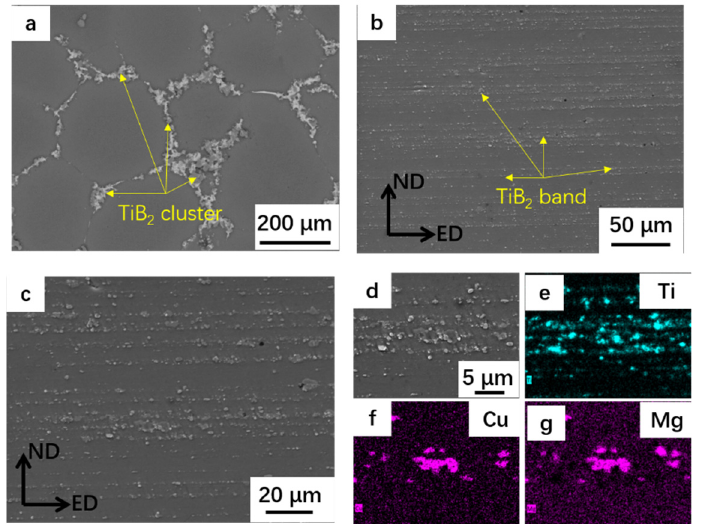
Figure 3. Scanning electron microscope (SEM) micrographs of composite:( a ) as-cast composites; ( b ) AOEPed composites; ( c , d ) are the magnification images; and ( e – g ) are the corresponding energy dispersive X-ray spectrometer (EDX) mappings of Ti, Cu and Mg in ( d ). ED: extrusion direction; ND: normal direction.